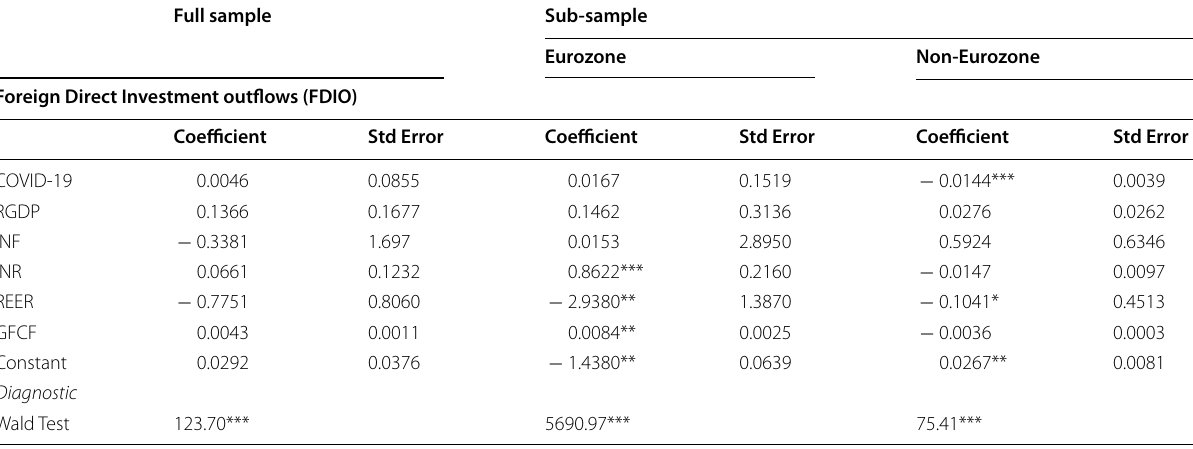
*** , **, and * represent the significance of the unit root model at the 1, 5, and 10%